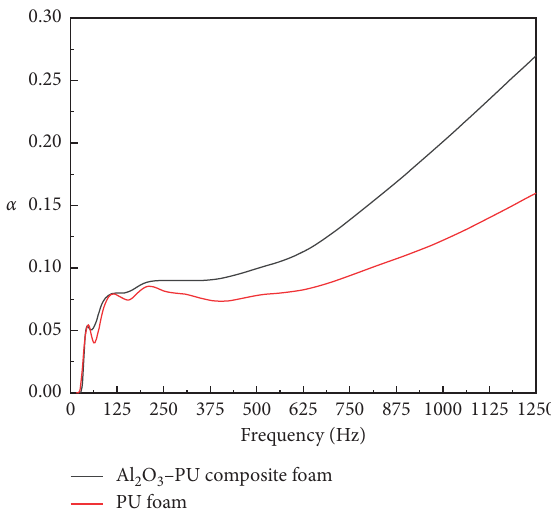
Figure 3: Sound absorption coefficient ( α ) diagram of PU foam and Al 2 O 3 -PU